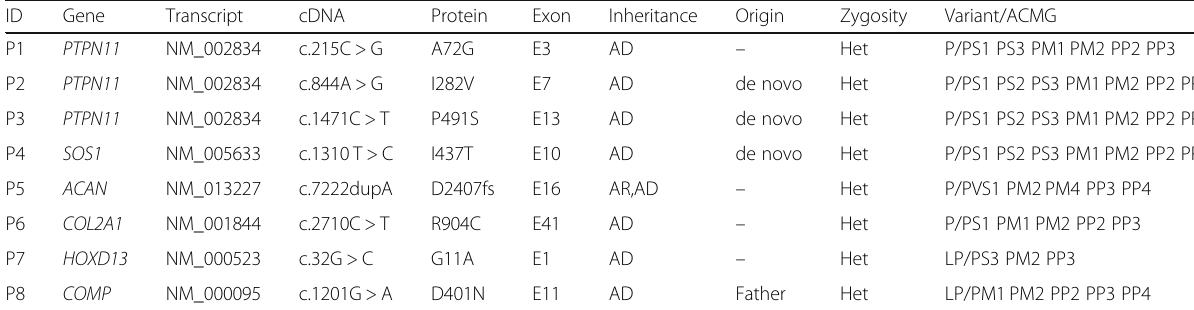
Table 3 Genetic variants